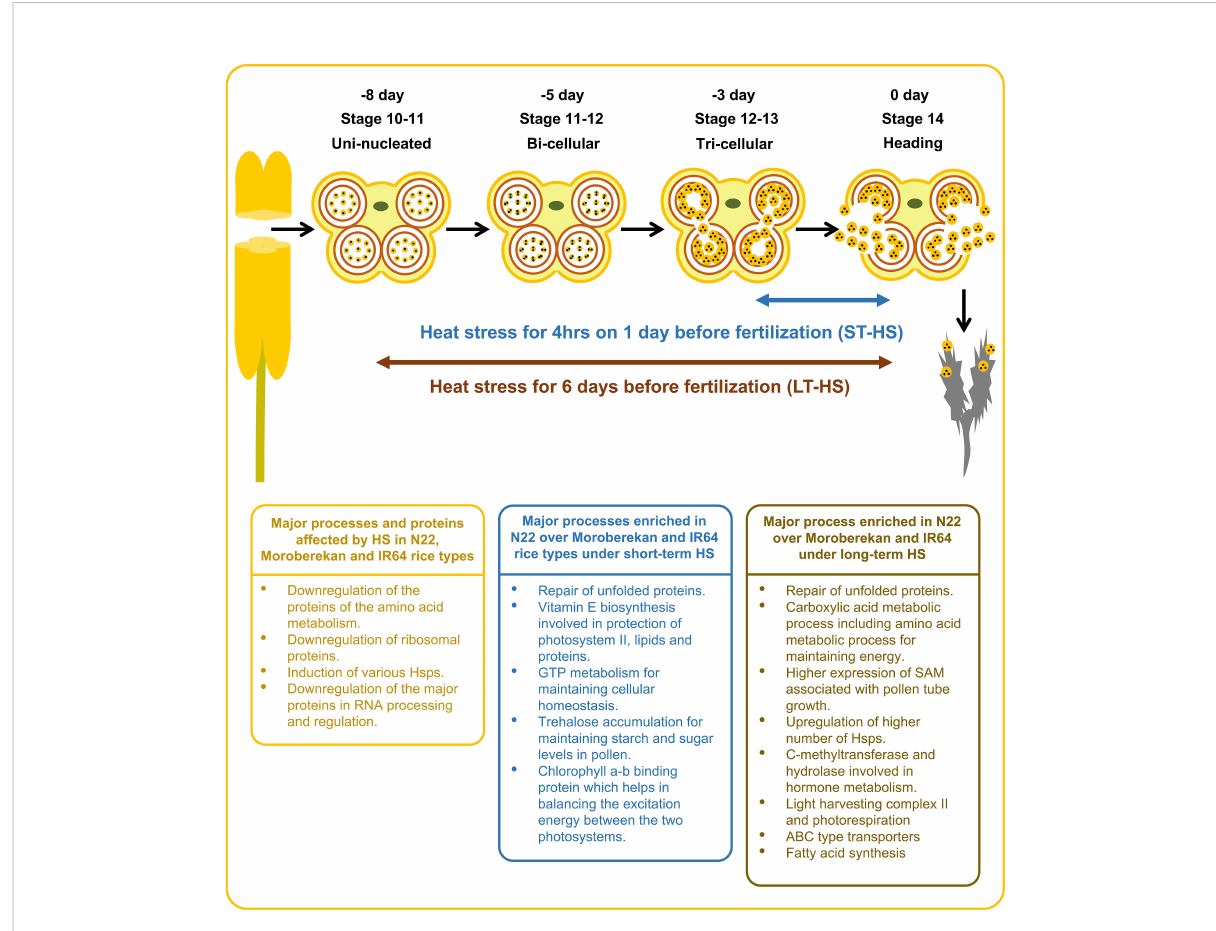
FIGURE 8 Illustration showing the effects of heat stress on major biological processes and the enriched biological processes in N22 over Moroberekan and IR64 in response to short-term and long-term HS conditions. ST, Short term heat stress and LT, Long-term heat stress